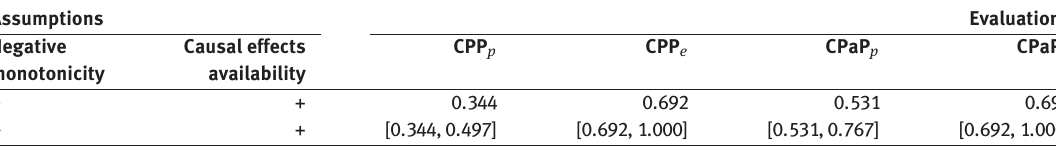
Table 2: Results from an example of the experimental